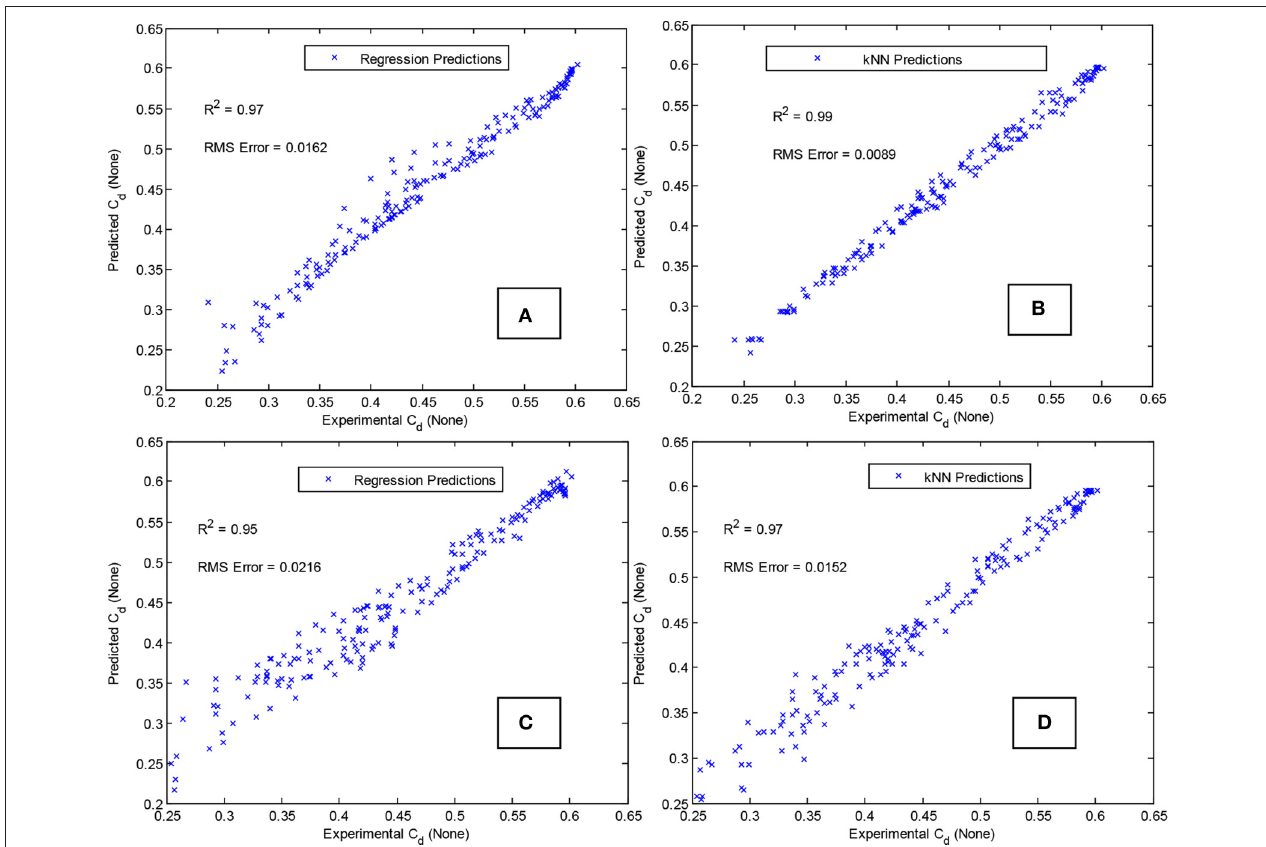
FIGURE 6 | (A,B) Predictive accuracy of quadratic η - ξ surface using regression (A) and k -Nearest Neighbor algorithm (B) . (C,D) Corresponding results without using average measured velocity (unknown for most practical applications). Regression results (C) and k -Nearest Neighbor algorithm results (D) using velocity calculated from isentropic relations.